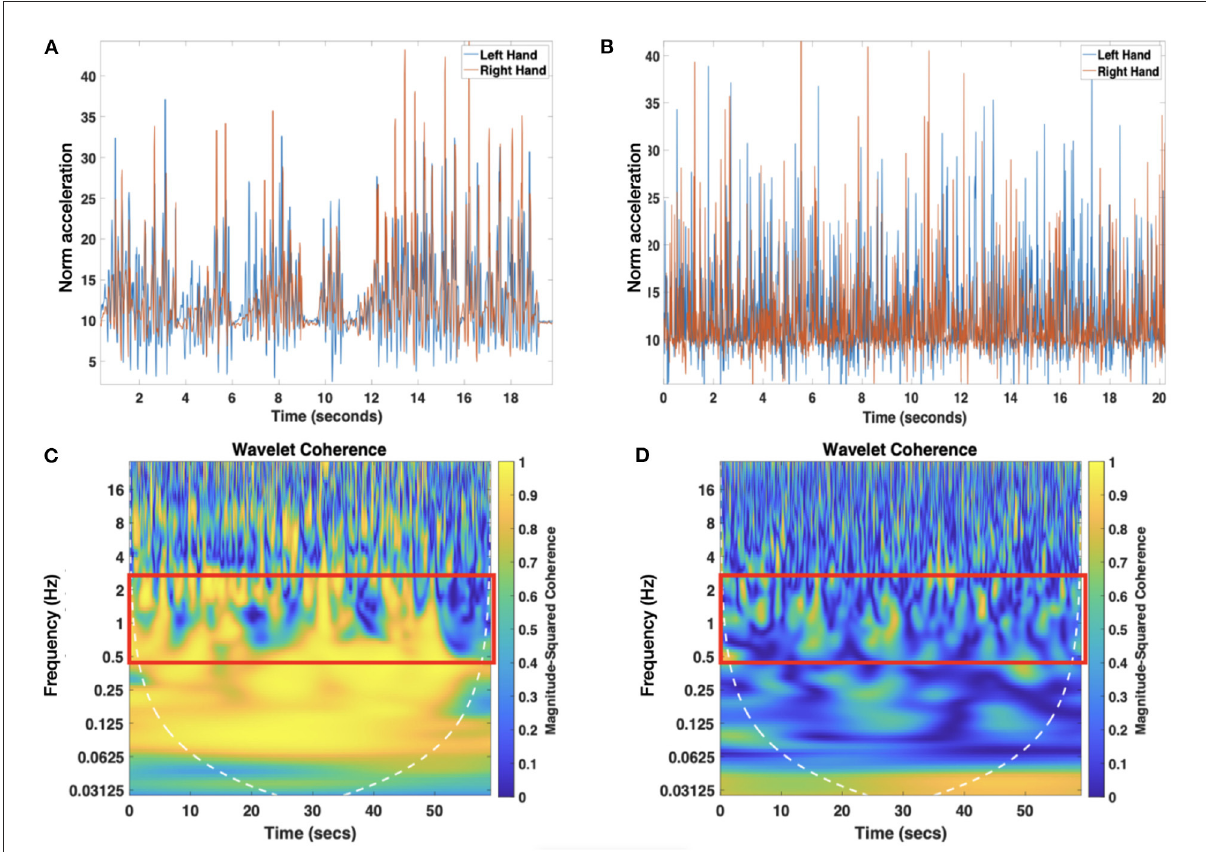
FIGURE2 Example of the time series created by joining together the rattling episodes of both arms using the manually annotated data (A) . Panel (B) represents the randomized version of the rattling time series. Only the first 20 s are shown to ease representation. Panels (C,D) represent the wavelet coherence spectra of movements of both arms using the original rattling time series and the randomized version, respectively. Highlighted with a red rectangle are the areas where the average wavelet coherence was